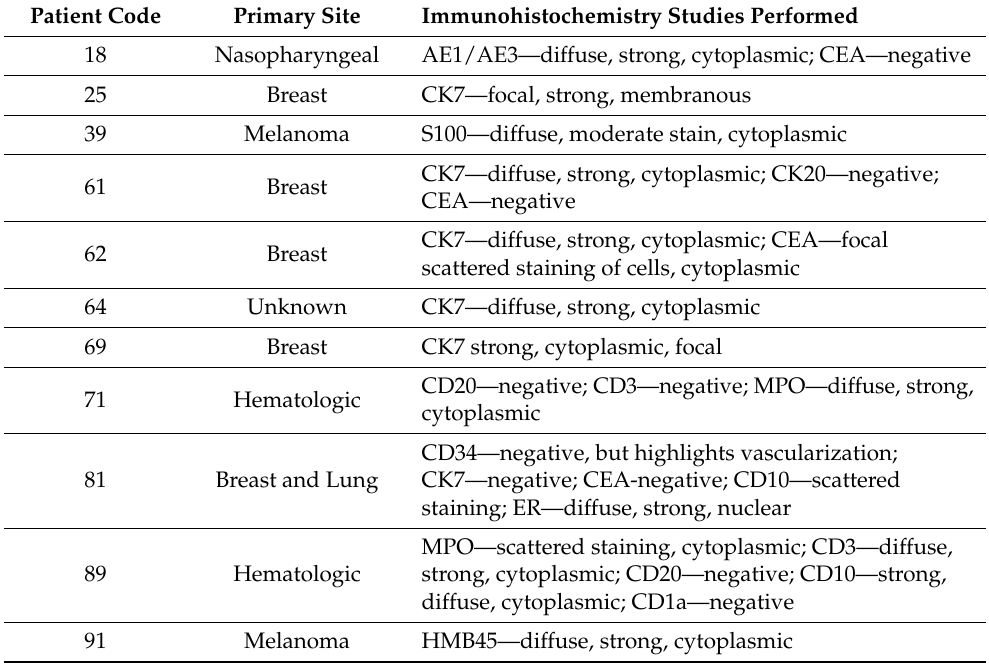
Table 4. Immunohistochemical staining performed in the